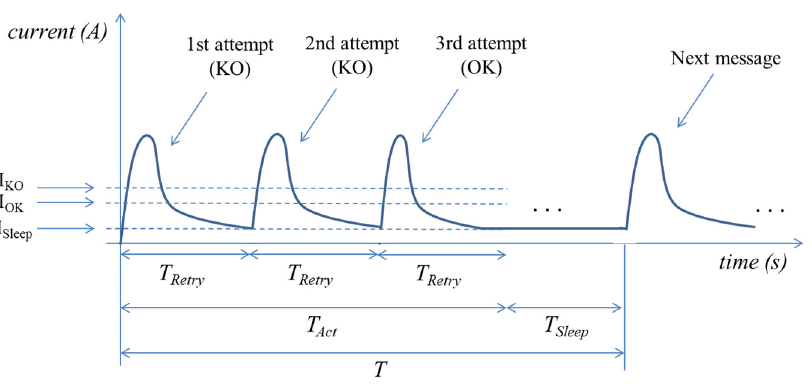
Figure 6. Device current consumption over time, where three transmission attempts are needed for successful delivery of a message. The main current and time parameters of the model are indicated in the figure.